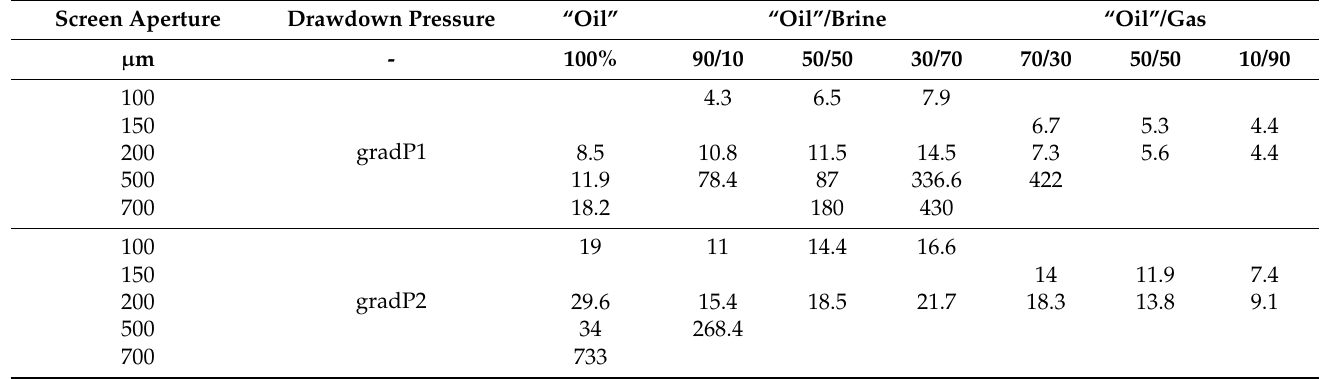
Table 1. Generalized results of filtration tests on bulk with different content of phases in the flow for PSD A (larger)—Suspended solids concentration is presented in grams/liters.